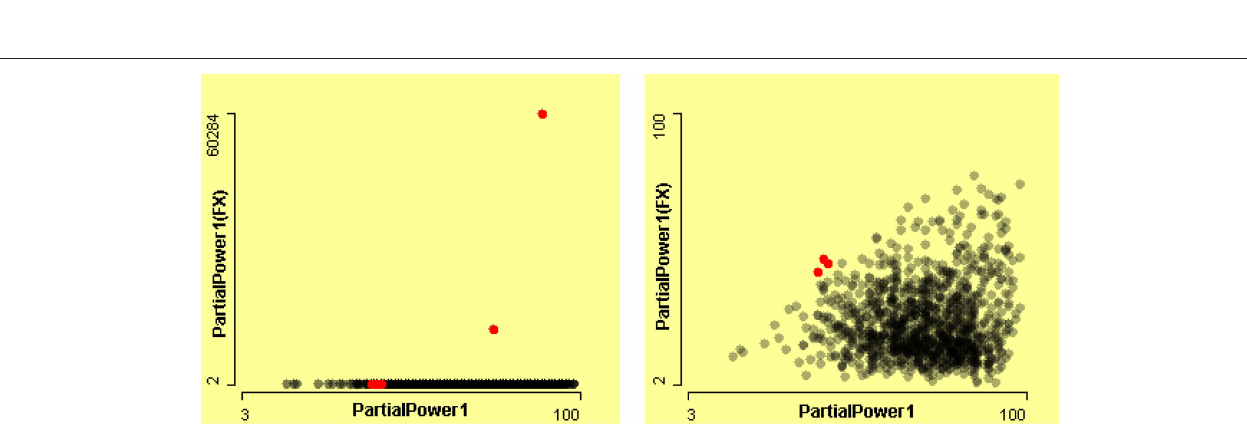
FIgurE 18 | Scatterplots of PartialPower1(FX) by PartialPower 1. The left-hand plot presents all of the data. The right-hand plot presents a zoom of almost 10 − 3 on the y -axis. These cases are highlighted using a linked histogram of the difference of these two